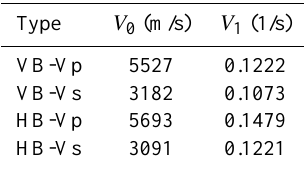
Figure 2. (a) A synthetic nhBm s(z) corresponding to a simulated multi-layer geological model. (b) Local changes of the Hurst parameter H(z) obtained by PA. Blue: theoretical H values, Red: calculated H values and Grey: layer limits. Table 4. Least-squares fitting coefficients ( V 0 and V 1 ) related to sonic logs (VB, pilot borehole; HB, main